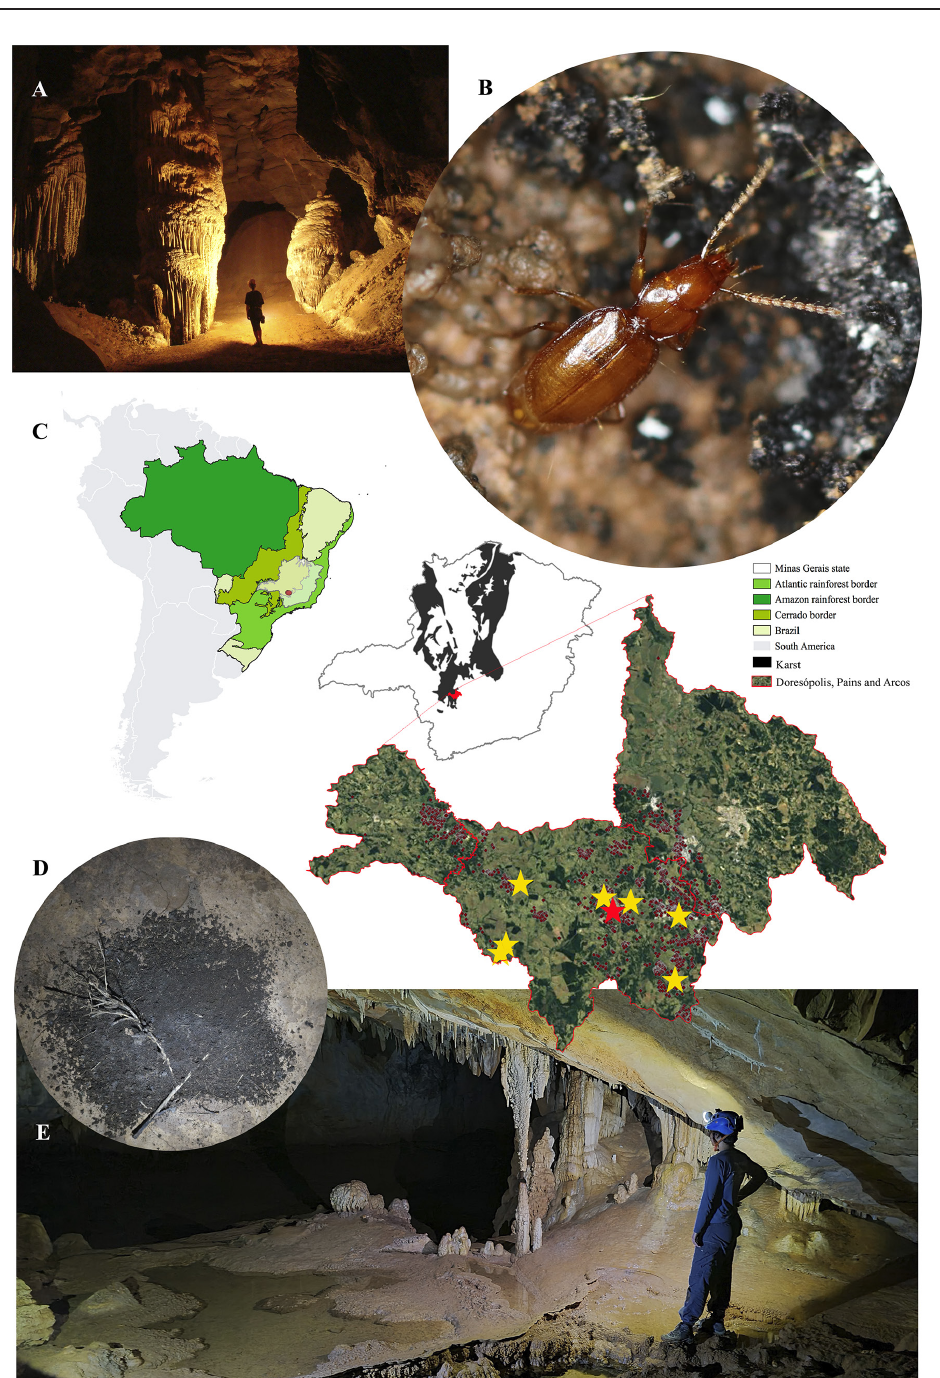
Fig. 5. Geographic localization of P. ( Neoperigona ) spelunca sp. nov. A . Éden cave, type locality. B . Perigona spelunca sp. nov. living specimen. C . Map of South America highlighting Brazil, Amazon rainforest, Atlantic rainforest and Cerrado Biomes, Minas Gerais state and the municipalities of Arcos, Pains and Doresópolis; the black areas correspond to the limestone groups in South America; the red dots represent all caves registered in the highlighted municipalities; the red star corresponds to Éden cave type locality and the yellow stars correspond to the others caves where P. spelunca sp. nov. was found. D . A small guano pile at Santuário cave. E . Santuário cave. (Photographs A and D are by Robson de Almeida Zampaulo; B and E are by Rodrigo L.